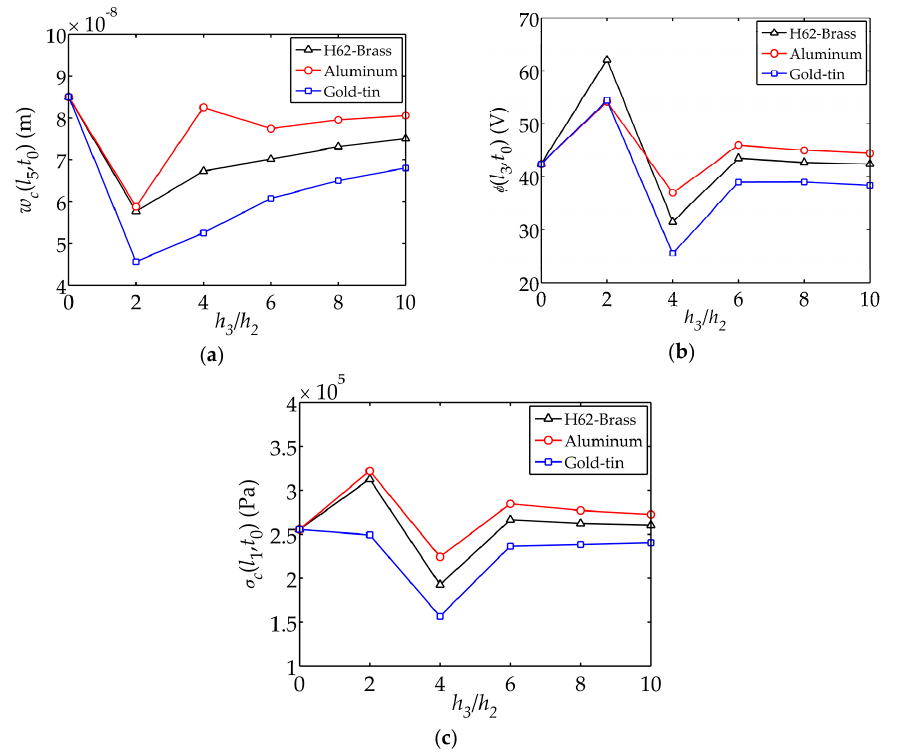
Figure 5. Displacement w c ( l 5 , (cid:1872) (cid:2868) ), electric potential ϕ ( l 3 , (cid:1872) (cid:2868) ) and stress (cid:2026) (cid:3030) ( l 1 , (cid:1872) (cid:2868) ) changing with versus the thickness ratio h 3 /h 2 : ( a ) Displacement w c ( l 5 , (cid:1872) (cid:2868) ); ( b ) Electric potential ϕ ( l 3 , (cid:1872) (cid:2868) ); ( c ) Stress (cid:2026) (cid:3030) ( l 1 , (cid:1872) (cid:2868) ).